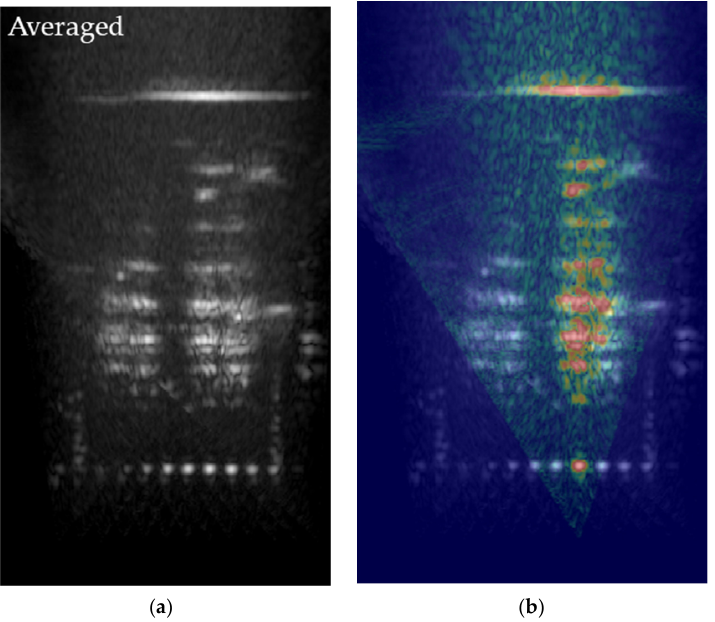
Figure 5. Multistatic GB-SAR after removing azimuth multiples. ( a ) An averaged image of all the images with various stationary antennae. ( b ) The scene #2 image in RGB color overlying the averaged image. Note that multiples were removed successfully.